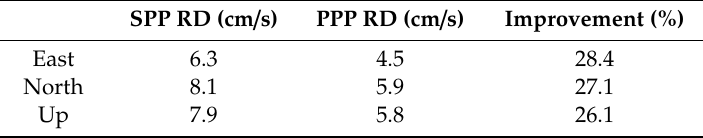
Figure3. BDS-2singlepointpositioning(SPP)( left )andPPP( right )RDvelocityerrorsofthevehicle–borne experiment. The red circle marks epochs blocked by buildings and trees. Table 3. RMS statistics and comparison of the vehicle–borne experiment.